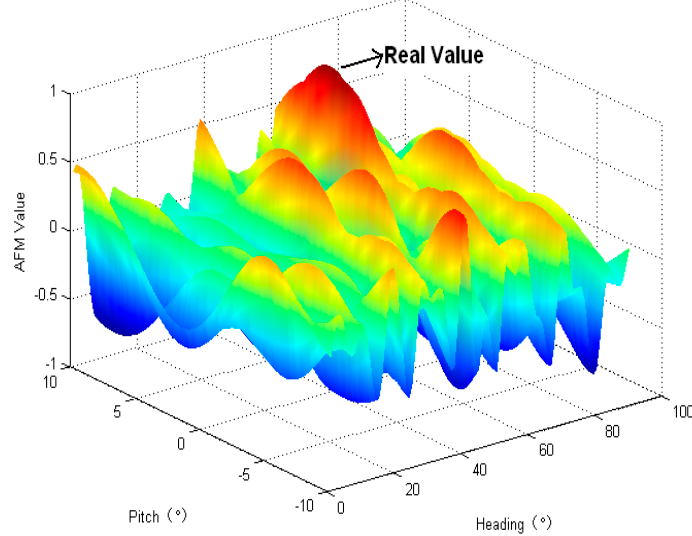
Figure 11. Adaptive function value demonstration.